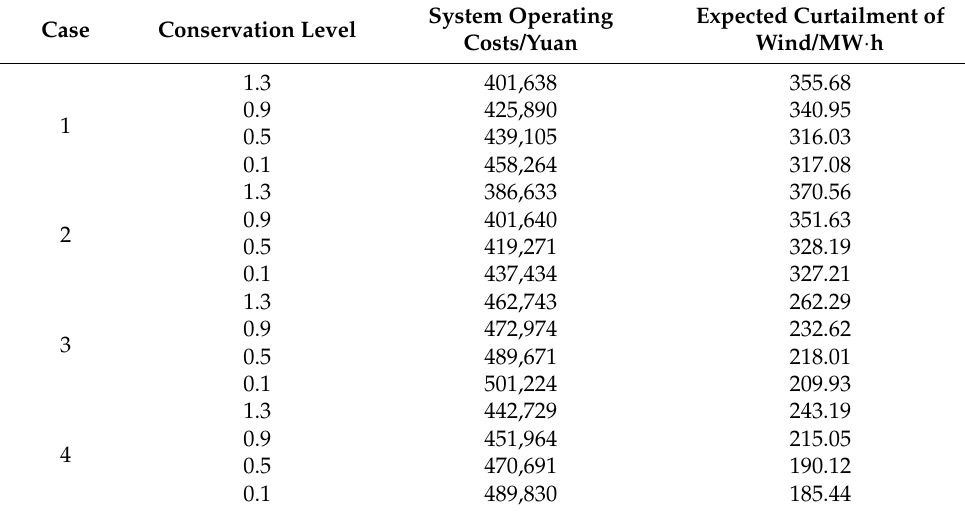
Table 8. Energy storage system capacity configuration